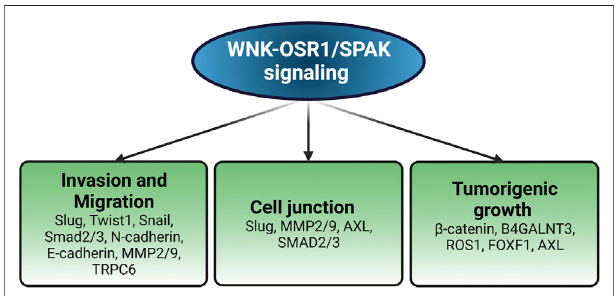
FIGURE 1 | Pathological impacts of WNK1 in cancer. WNK1 regulates the expression of various molecules involved in different aspects of oncogenesis. Created with